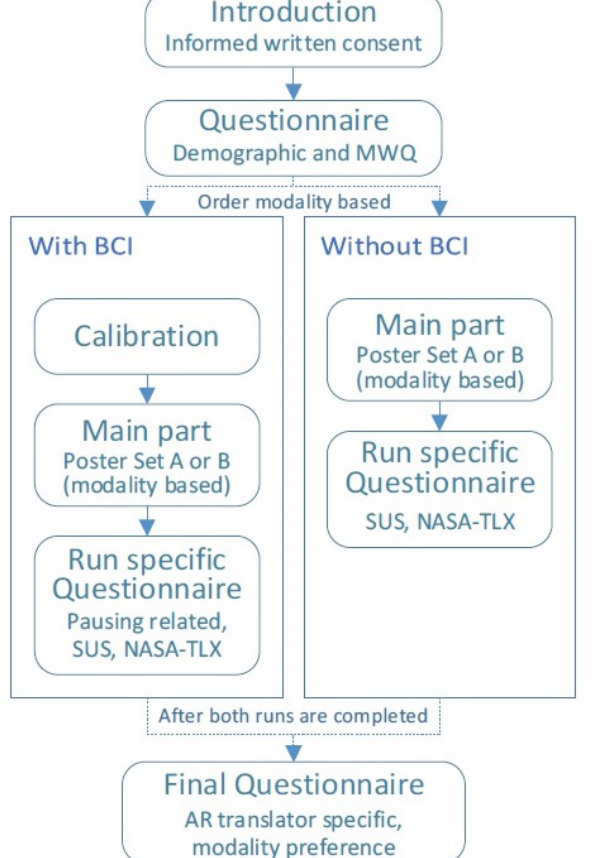
Figure 4. User study procedure overview for the two runs (with and without the BCI to make the system